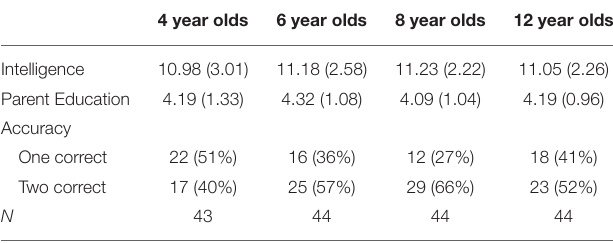
TABLE 3 | Descriptive statistics by age